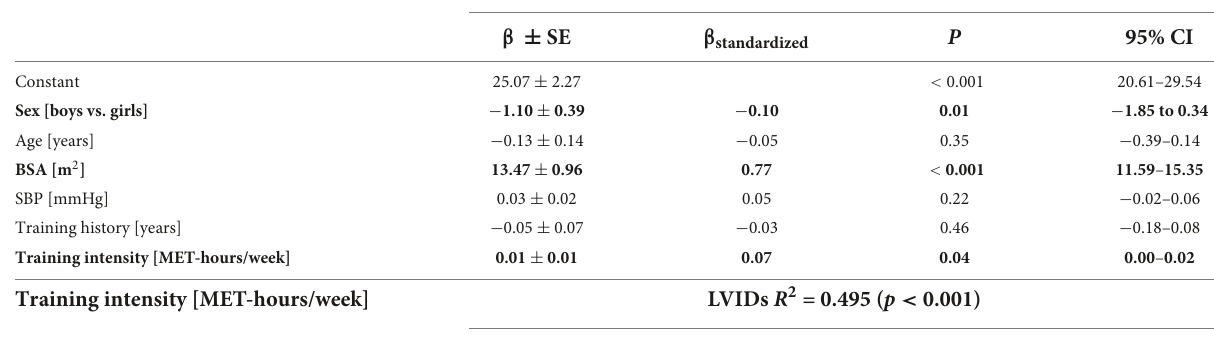
TABLE 3 Results of linear multi-regression analysis controlled for sex, age, body surface area, systolic blood pressure, training history, and training intensity or maximum aerobic capacity, respectively. Training intensity [MET-hours/week] LVIDd R 2 = 0.610 ( p <